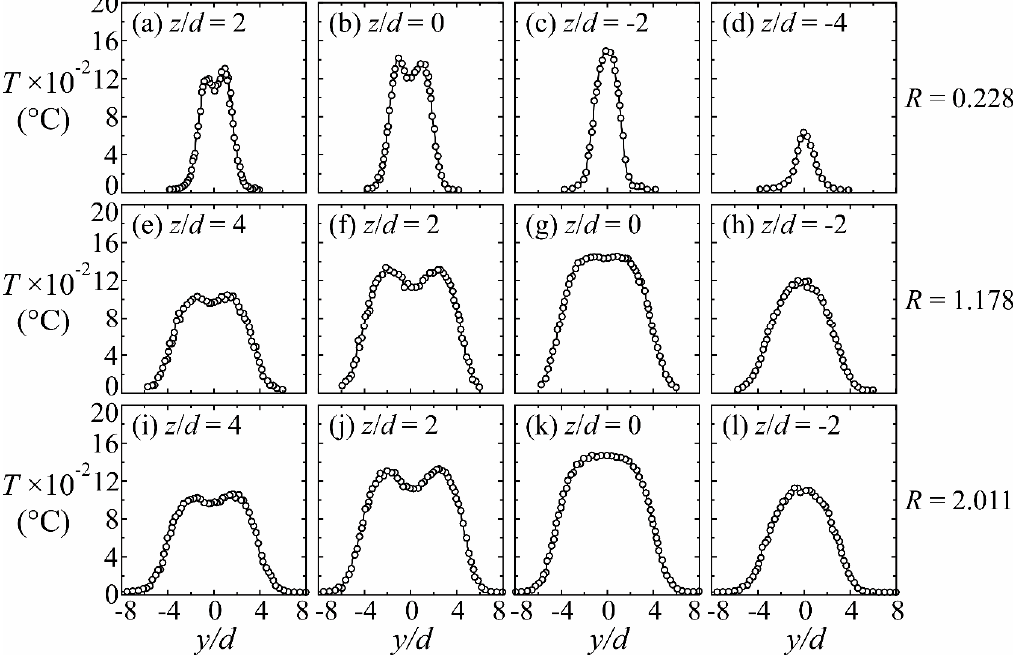
Figure 12. Time-averaged temperature distributions at x/d = 30. R = 0.228, 1.178, and 2.011. θ = 15°.